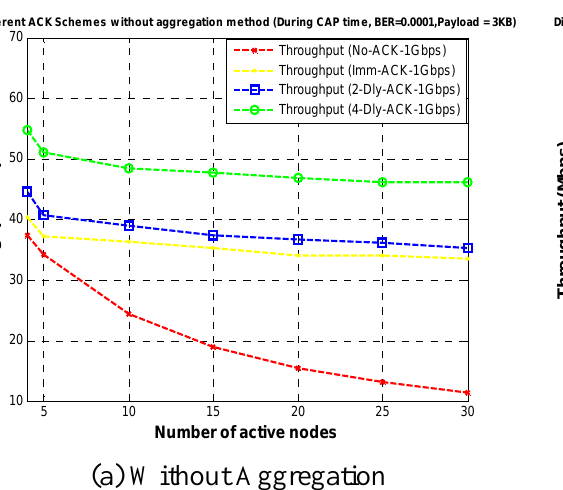
Figure 14. Throughput versus number of active nodes with IB as a backoff